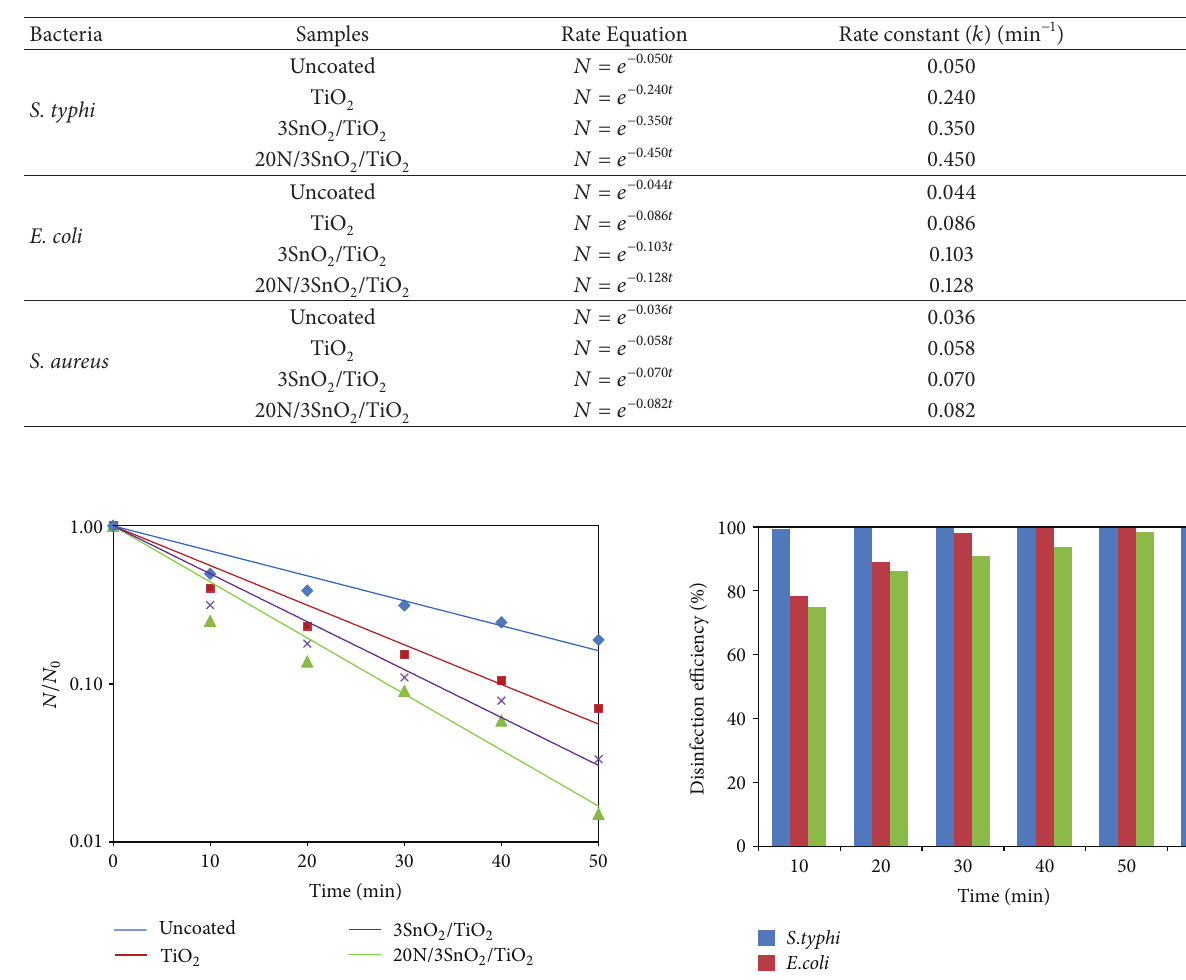
Table 3: A summary of numerical fits of first-order kinetics to the inactivation of bacteria.